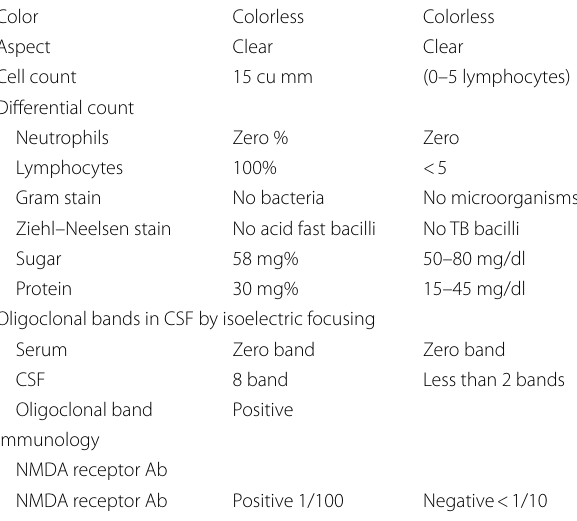
Table 2 CSF analysis, oligoclonal bands, and NMDA